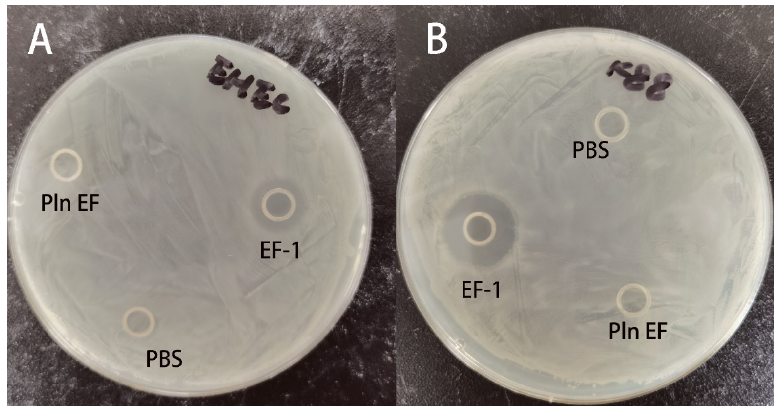
Figure 3. The inhibition zone of purified EF-1 (12.5 μM) and synthesized PlnEF (6.25 μM of PlnE and 6.25 μM of PlnF) against EHEC ( A ) and E. coli K88 ( B ) with sodium phosphate buffer as a negative control.